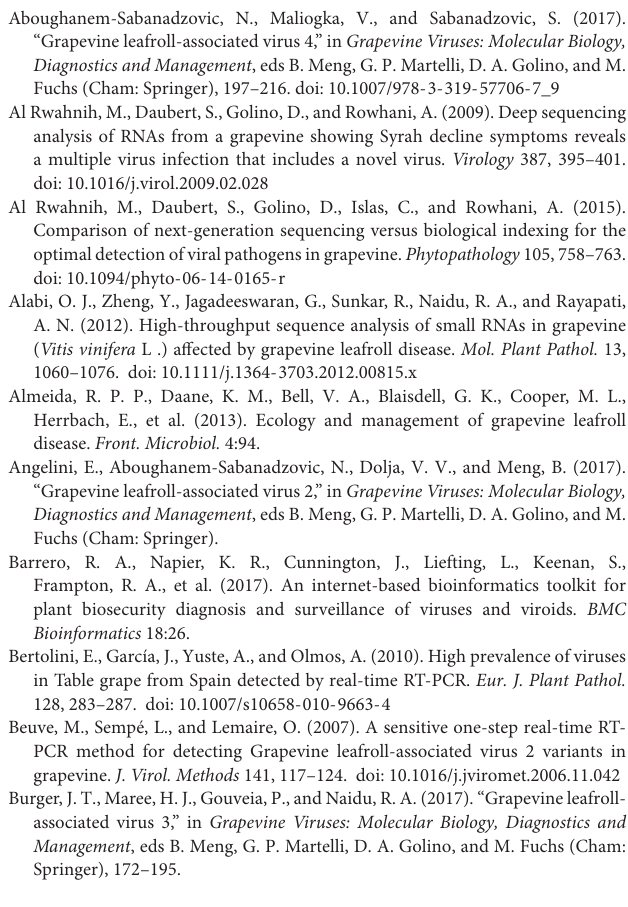
Supplementary Figure 4 | (Left) Distribution of vsiRNA reads of different lengths that align to reference virus sequences. Negative numbers refer to vsiRNAs aligned to the negative strand of the viral genome. (Right) Alignment of the 21 nt class vsiRNAs (reads) to the viral genomes of GLRaV-1, GLRaV-2 variant 95/933,